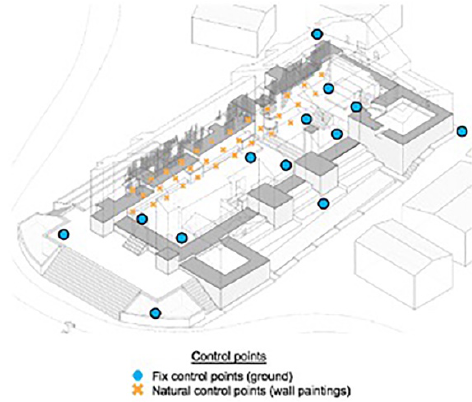
Figure 8 . Fixed and natural control points (geodetic network).